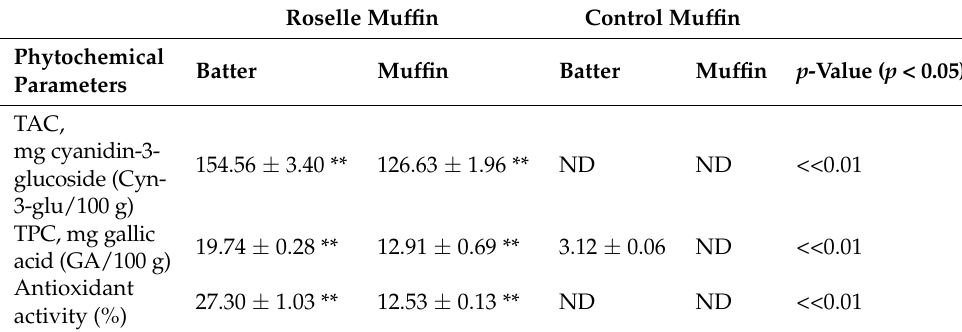
Table 6. Phytochemical content of batter and muffin.